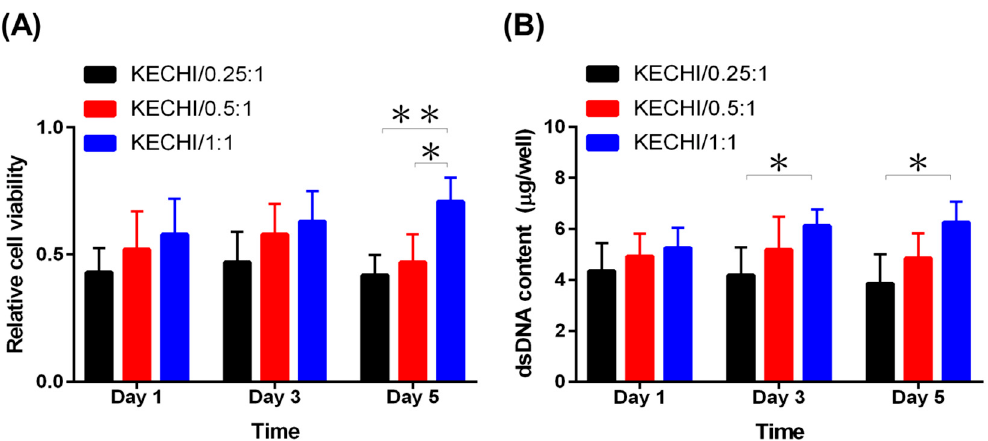
Figure 7. Viability of L929 cells on the keratin/chitosan membrane at days 1, 3, and 5 of cell culture. ( A ) WST-1 assay of L929 cells on KECHI/0.25:1, KECHI/0.5:1, and KECHI/1:1 membranes. ( B ) Proliferation of L929 cells in contact with keratin/chitosan membranes by measuring dsDNA content. * p < 0.05, ** p < 0.01.